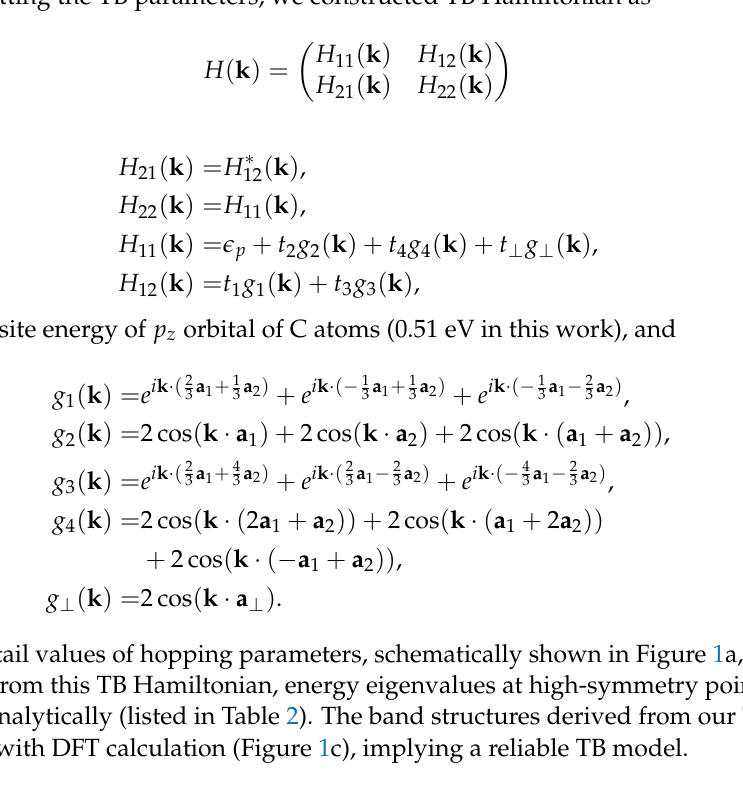
Table 1. Hopping parameters t i (in eV) assigned to the simple TB Hamiltonian of AA-stacking graphite. d is the distance between the atomic sites on which the interacting orbitals are